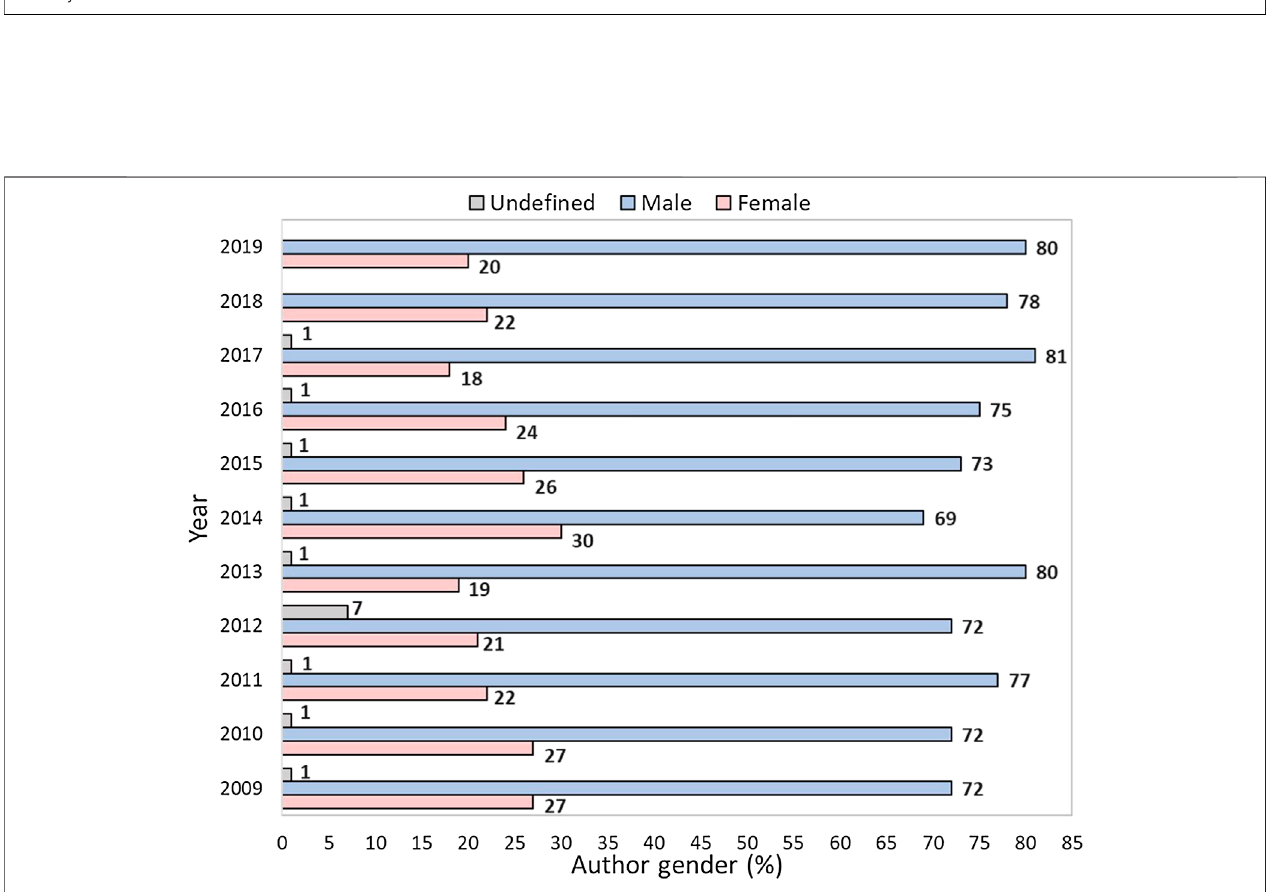
FIGURE 3 | Gender distribution of the fi rst 100 most proli fi c authors publishing on alkali-activated materials in the years 2009 – 2019.